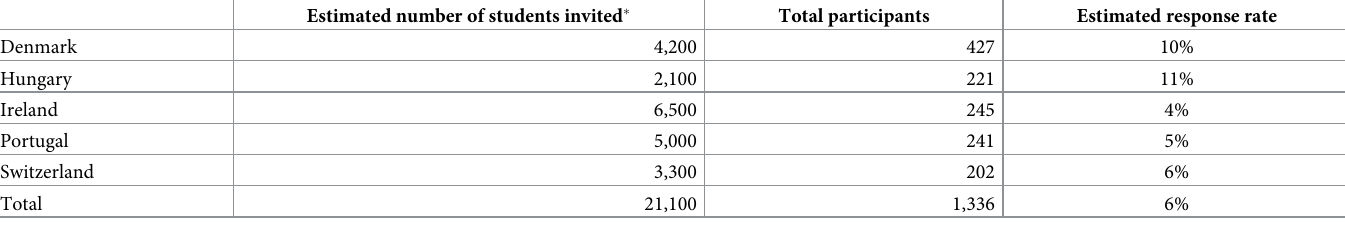
Table 1. Overview of the population and sample